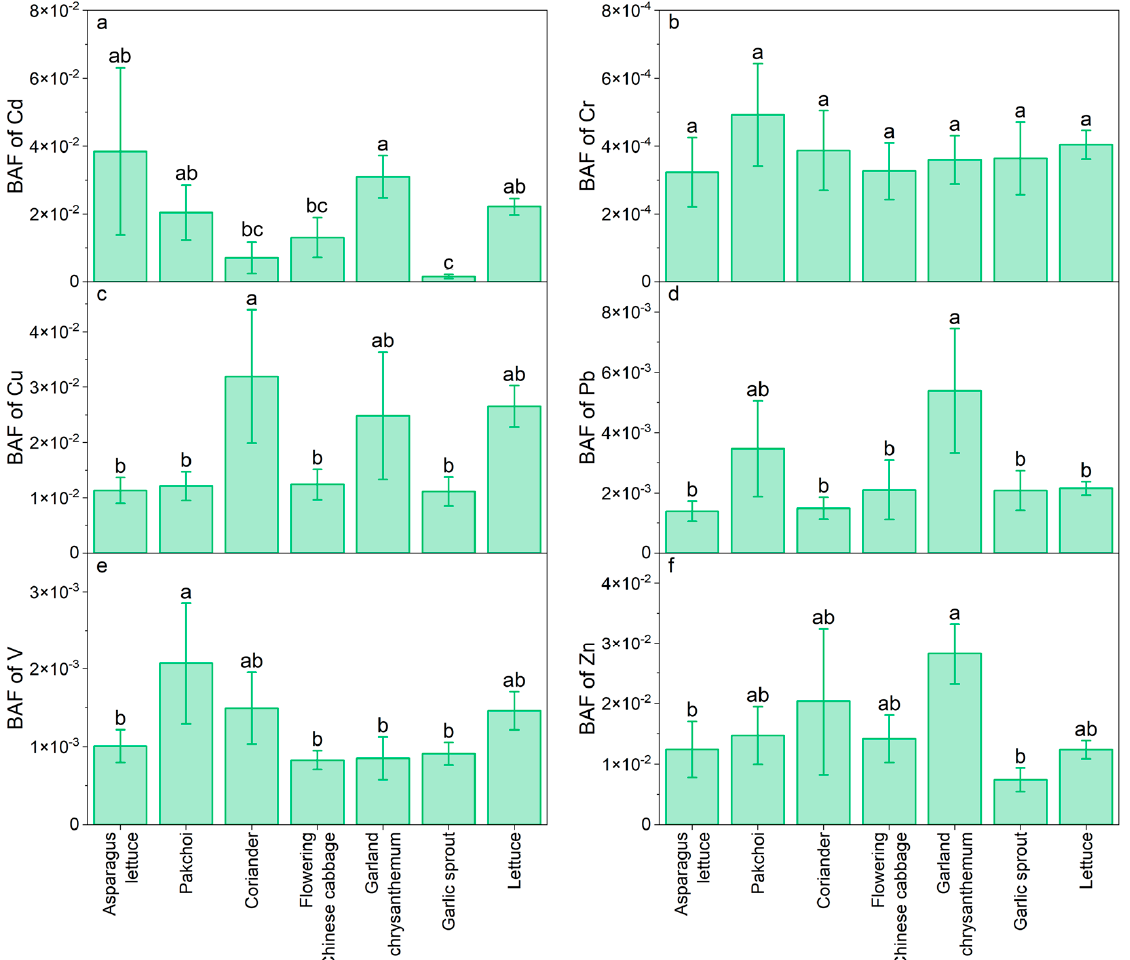
Figure 5. The bioaccumulation factor (BAF) of trace metals in vegetables around the V-containing stone coal smelting site. ( a – f ) represents the BAF of Cd, Cr, Cu, Pb, V, and Zn, respectively. Values followed by different lowercase letters are significantly different at α = 0.05.